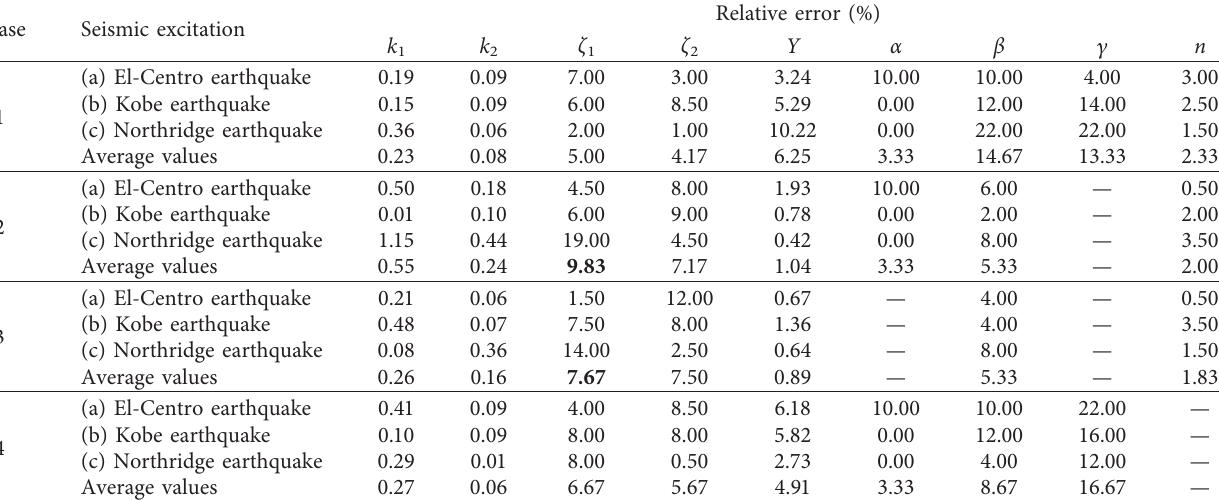
Table 4: The relative errors between identified parameters and actual model